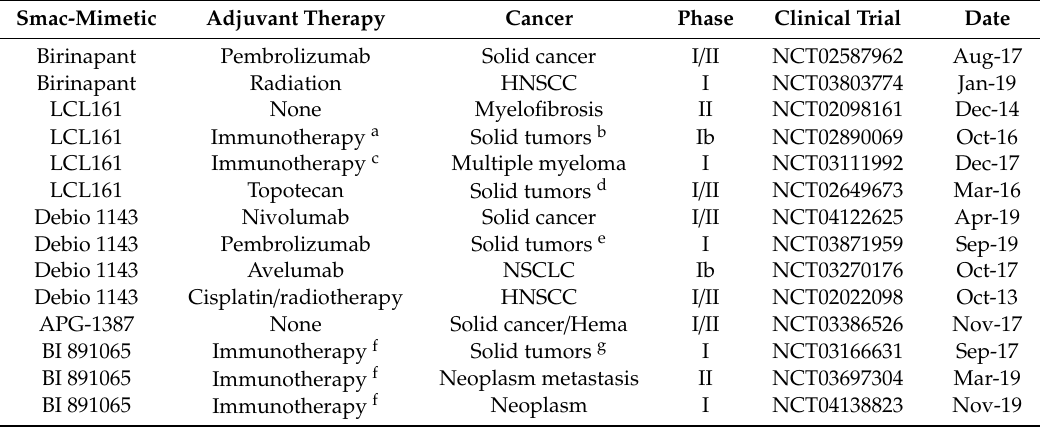
Table 2. In progress clinical Smac-Mimetic